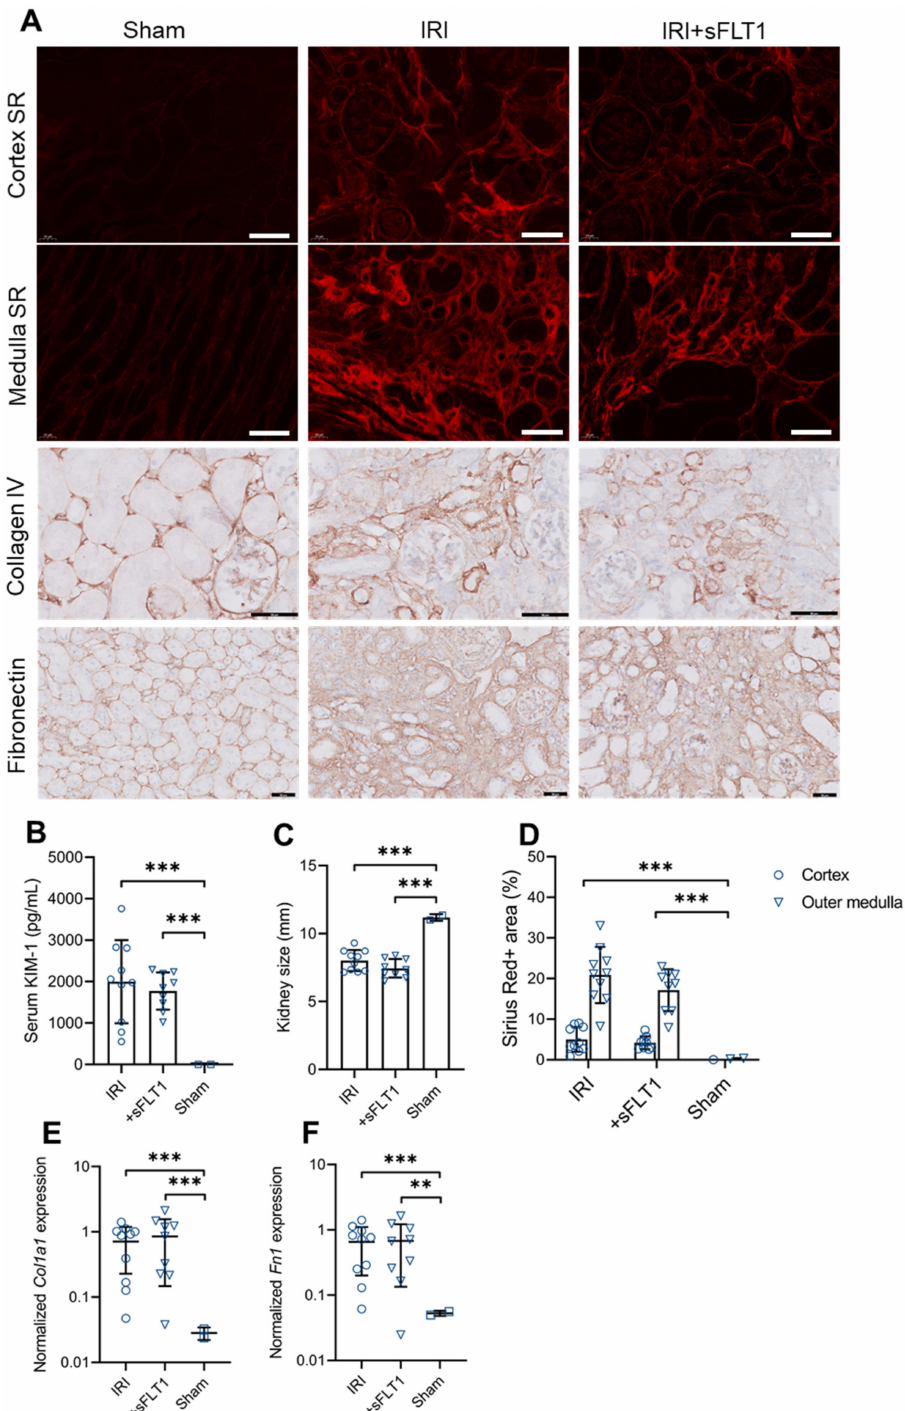
Figure 2. sFLT1 does not accelerate AKI-to-CKD progression. One week after transfection, control and sFlt1 -transfected mice were subjected to 35 min of warm unilateral IRI. IRI and sham kidneys were harvested 28 days after surgery. ( A ) Representative images of Sirius red (SR) in renal cortex and outer medulla, collagen IV and fibronectin 28 days after IRI. Scale bars, 50 µ m. ( B ) Serum KIM-1 levels of mice were measured 48 h after IRI. One-way ANOVA. ( C ) the kidney pole-to-pole size was measured 28 days after IRI. One-way ANOVA. ( D ) The Sirius red-positive cortex and outer medulla areas were quantified. Linear mixed model analysis. ( E , F ) Quantitative PCR for ( E ) Col1a1 and ( F ) Fn1 was performed on whole-kidney mRNA. One-way ANOVA on log-transformed gene expression. *** p < 0.001, ** p <